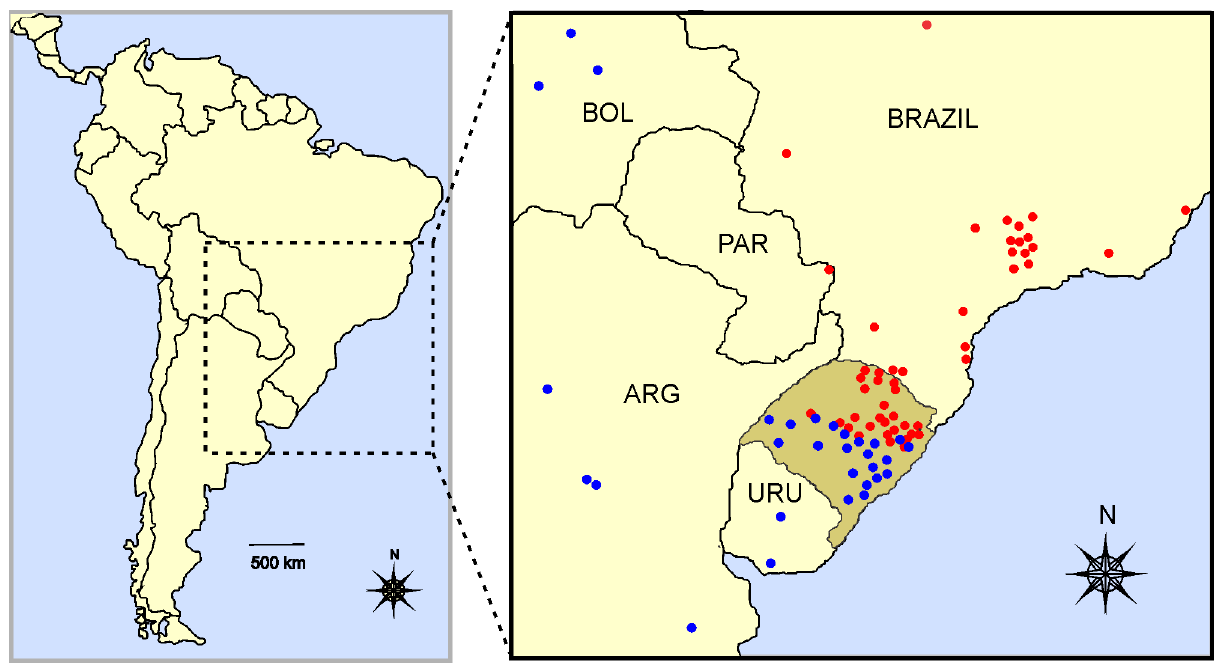
Figure 1. Map showing the location of the study area within South America (left), and an enlarged view (right) depicting sample collection points. Red and blue circles represent collection locales for Leopardus guttulus and L. geoffroyi , respectively. The area depicted in darker shading in the enlarged map is Rio Grande do Sul (RS) state, where hybridization between these species has been documented. Samples collected inside RS where included in the analyses as the hybridizing populations, while those sampled outside RS were putatively considered to comprise parental/control populations, pending on genetic assessments (see text for details).